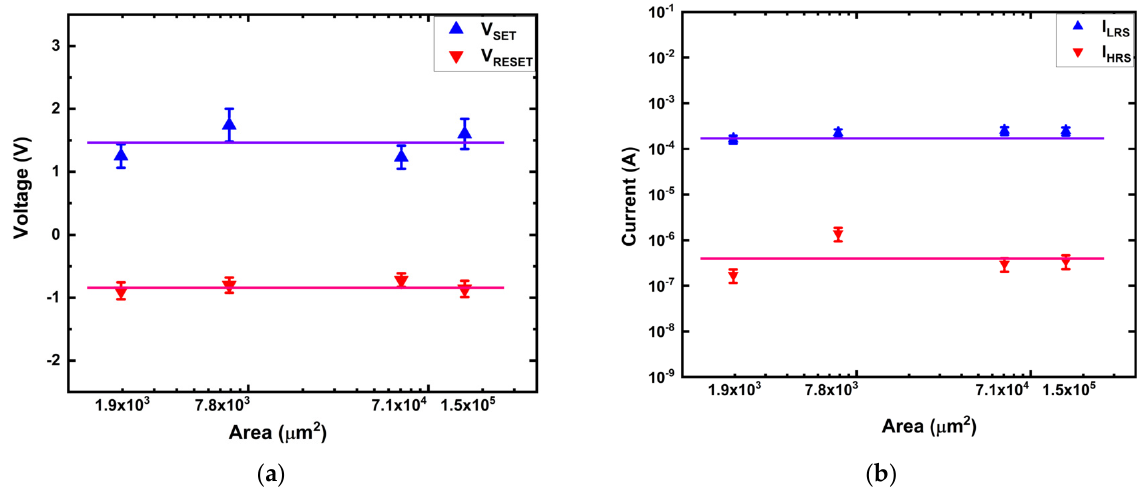
Figure 3. Area dependent characteristics of Ti/MgF x /Pt memory devices. ( a ) SET and RESET voltage vs. area; ( b ) On and Off current vs. area.